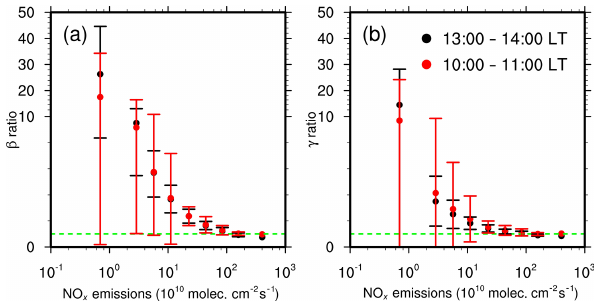
Figure 2. Distributions of β (a) and γ (b) ratios as a function of anthropogenic NO x emissions on weekdays for July 2011 over the CONUS. “13:00–14:00LT” is for OMI, and “10:00–11:00LT” is for SCIAMACHY and GOME-2A/2B. The data are binned into nine groups based on anthropogenic NO x emissions: E ∈ (0, 2 1 ) , [2 1 , 2 2 ) , [2 2 , 2 3 ) , [2 3 , 2 4 ) , [2 4 , 2 5 ) , [2 5 , 2 6 ) , [2 6 , 2 7 ) , [2 7 , 2 8 ) , [2 8 , 2 9 ) × 10 10 moleculescm − 2 s − 1 . Here, (0, 2 1 ) denotes 0 < emissions < 2 1 , and [2 1 , 2 2 ) denotes 2 1 ≤ emissions < 2 2 , sim- ilar to other intervals. The green dashed line denotes a value of 1. Error bars denote standard